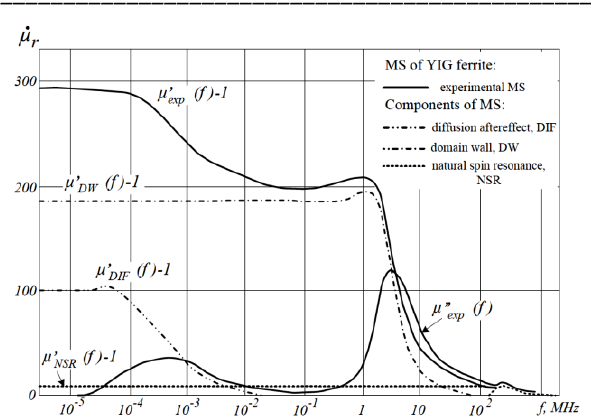
Fig. 13. KKR evaluation of NSR component of the measured [7] CIP